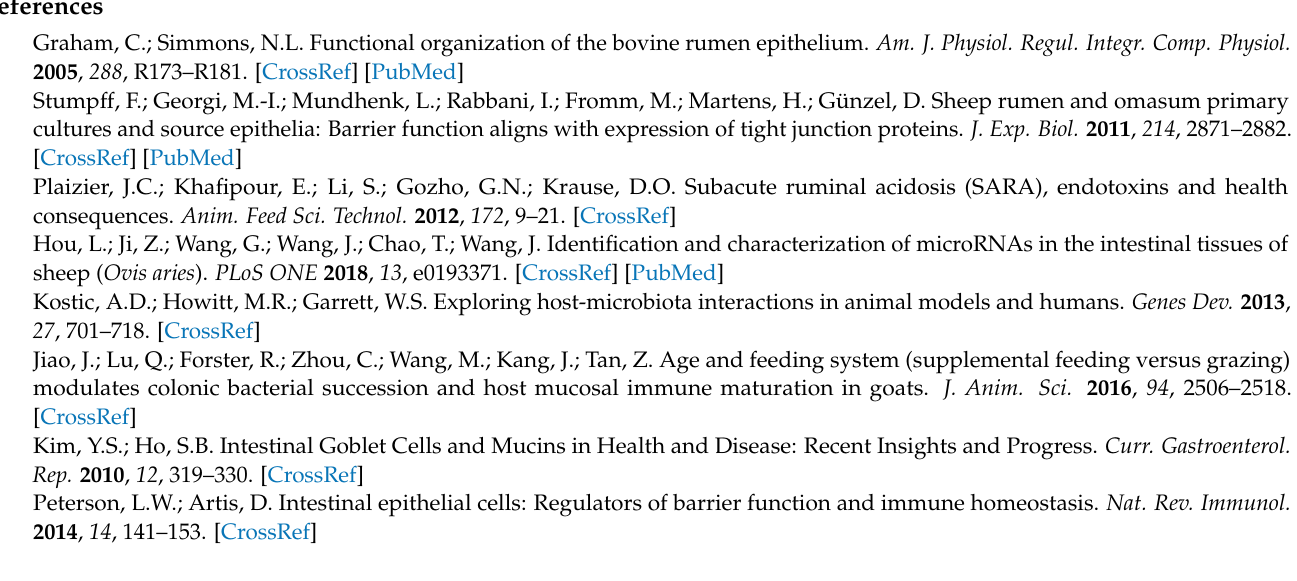
Table S3: information of the highly expressed miRNAs in the goat colon of three different periods; Table S4: the dynamic miRNAs in goat colon from D10 to D31; Table S5: the identified DEmiRNAs in the goat colon; Table S6: the enriched KEGG pathway of differentially expressed miRNAs in goat colon from D10 to D31; Table S7: the enriched KEGG pathway of highly expressed miRNAs in goat colon from D10 to